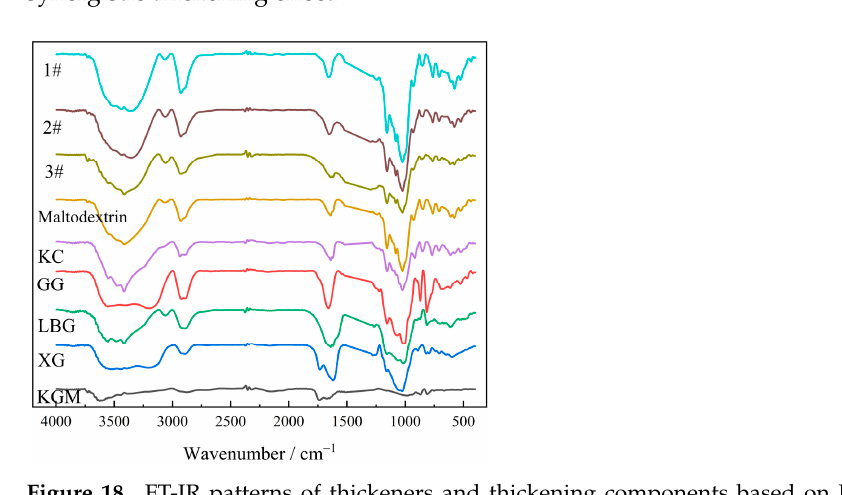
Figure 18. FT-IR patterns of thickeners and thickening components based on KGM for special medical use.